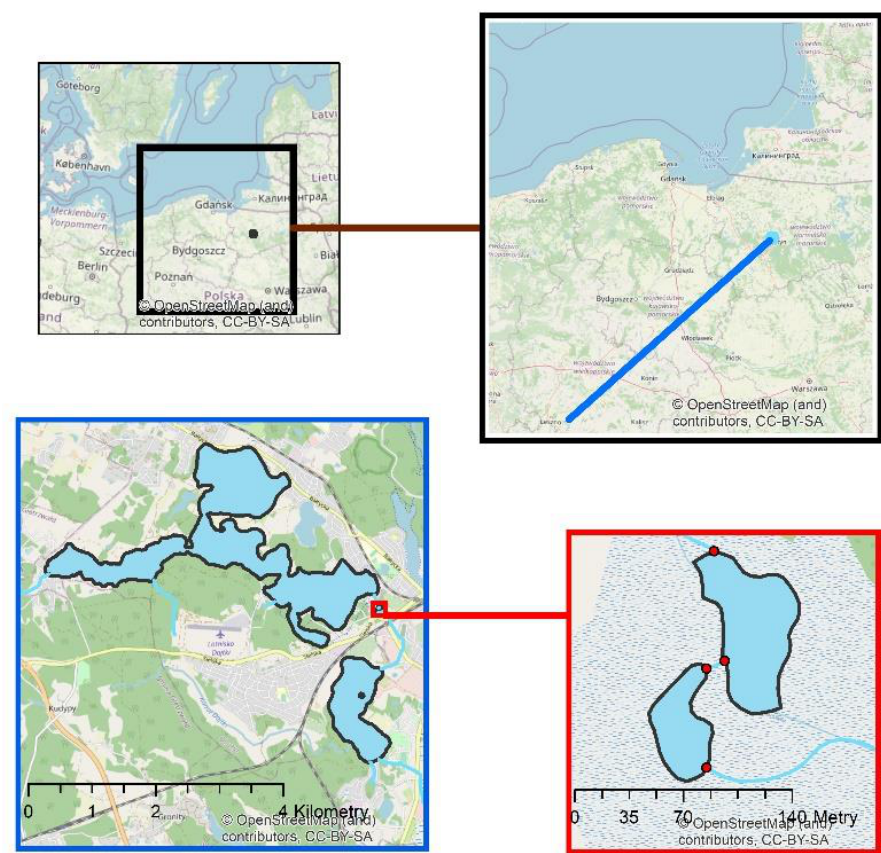
Figure 15. The analyzed object—four lakes connected by a river with seasonal streams flowing into the lakes.